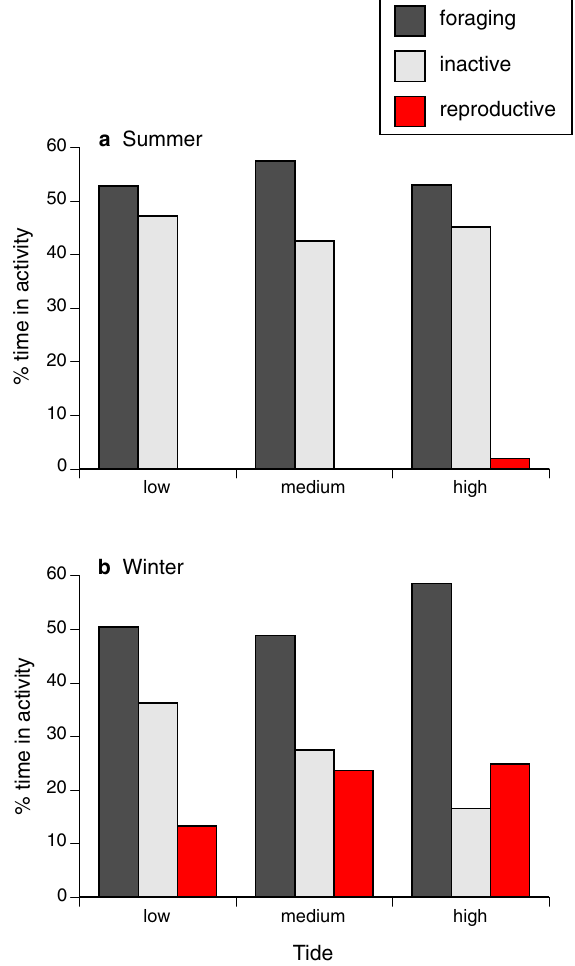
Figure 3. Interactive effects of tidal phase and season on the activity of sea snakes ( Emydocephalus annulatus ) in the Baie des Citrons, New